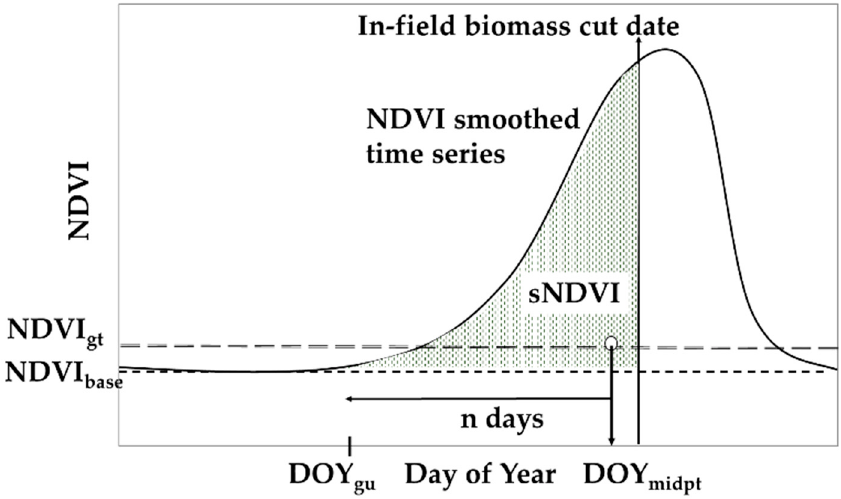
Figure 2. Key parameters used to determine sNDVI. See text for the description of the methodol- ogy.